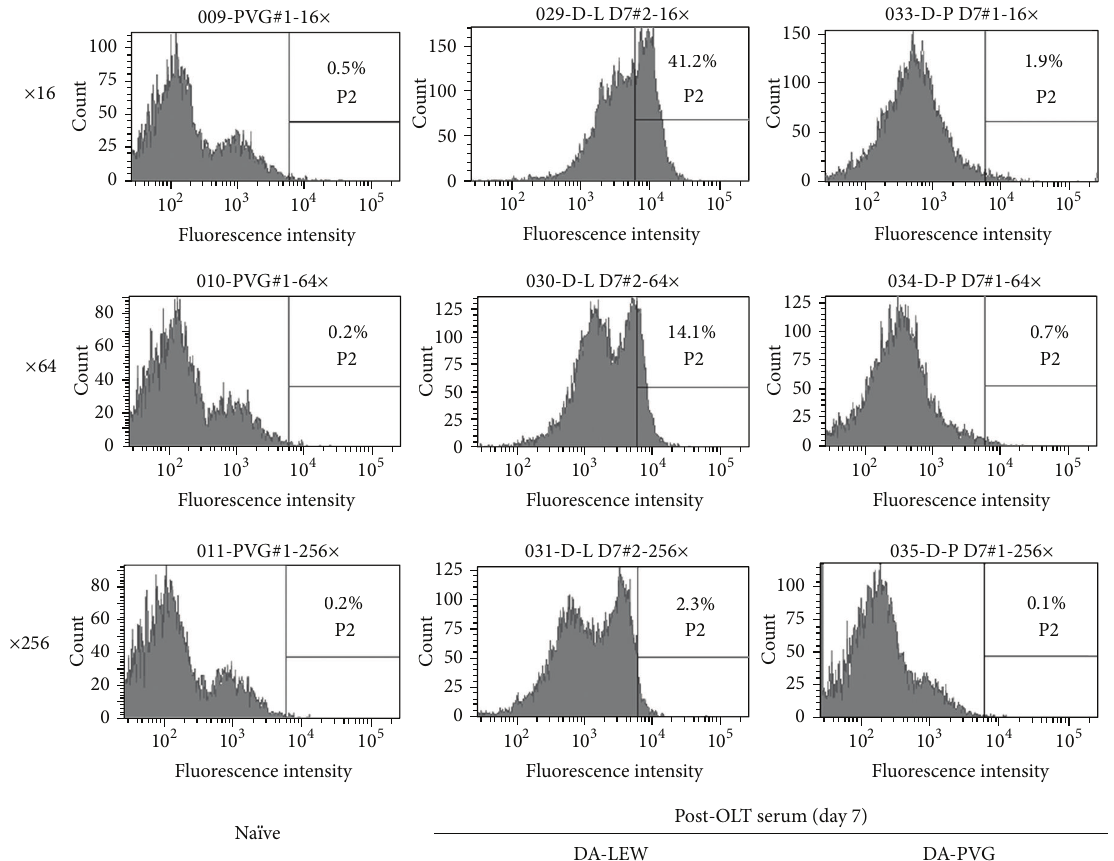
Figure 3: Alloantibody response during the rejection phase after OLT. The alloantibody response was measured by flow cytometry on a single cell suspension of DA rat splenocytes. Briefly, 50 𝜇 L aliquots containing 5×10 5 splenocytes was incubated with 50 𝜇 L of diluted naive or post- OLT sera (1: 16, 1:64, 1:256) for 45 min at 4 ∘ C. The washed cells were reacted with 50 𝜇 L of a mixture of FITC-conjugated goat antibody specific for the Fc portion of rat IgG ( ×100 dilution) (Jackson ImmunoResearch Laboratories, West Grove, PA, USA) in PBS containing 1% BSA and 0.02% NaN 3 . After staining, the cells were washed, fixed, and analyzed using an LSRII flow cytometer (BD Biosciences, San Jose, CA, USA). Histograms (representative of three individuals) show the percentage of DA splenocytes recognized by alloantibody (IgG) in the post-OLT sera at day 7 after